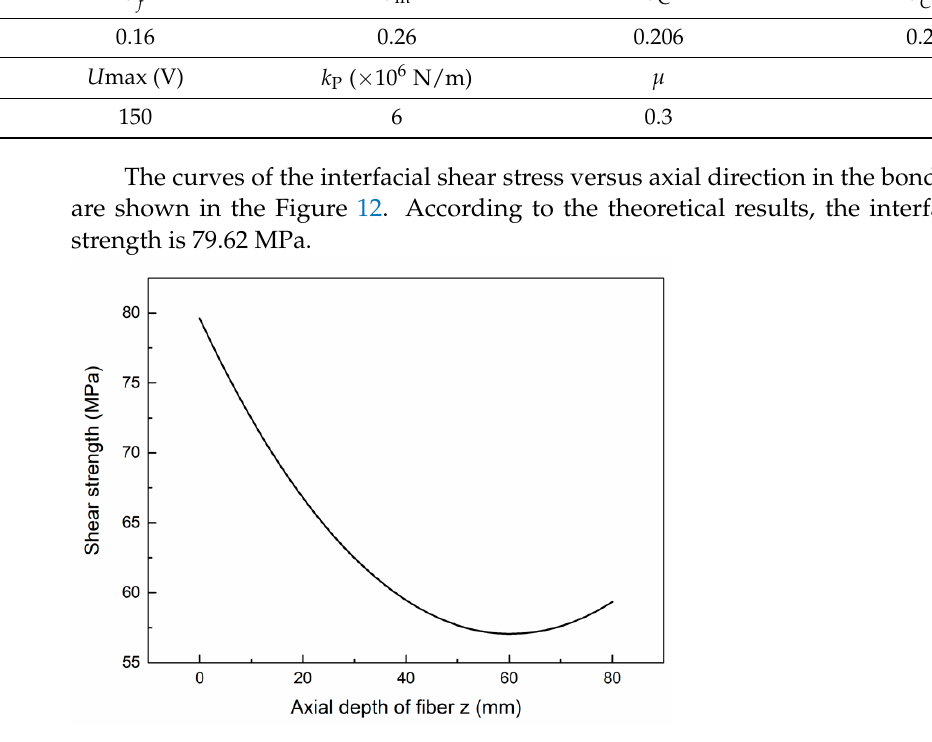
Figure 12. Interfacial shear stress versus axial direction in the bonding region.